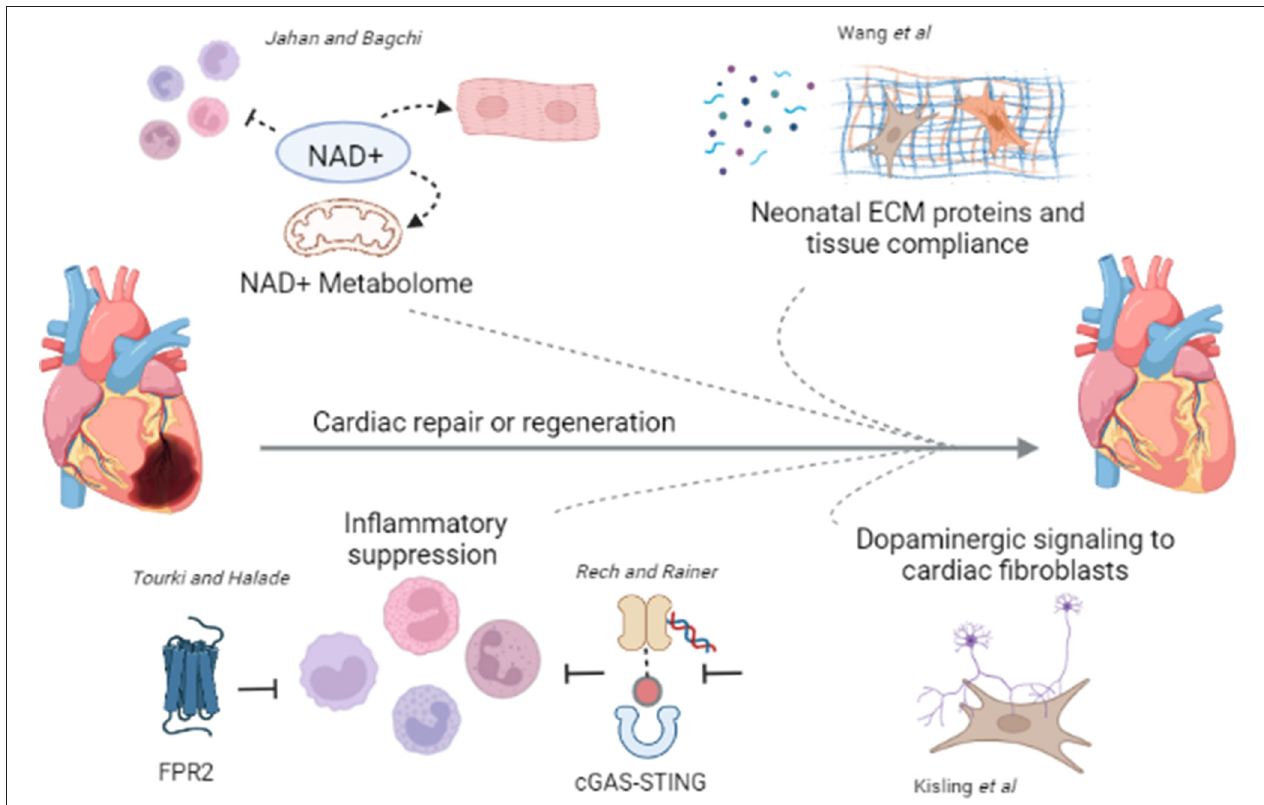
FIGURE 1 | Broad and diverse mechanisms contribute to cardiac repair or regeneration. In the current topic issue, articles review the literature regarding NAD + metabolome in CVD (Jahan and Bagchi), and inflammatory suppression via FRP2 activation (Tourki and Halade) or cGAS-STING inhibition (Rech and Rainer) in cardiac repair. Primary research articles demonstrate a role for ECM proteins and tissue compliance in cardiac regeneration ( Wang et al.), and dopaminergic signaling to cardiac fibroblasts in cardiac repair post MI (Kisling et al.). Future studies should assess what molecular triggers can tip the balance to limit adverse remodeling and the pathogenesis of HF promoting the reparative processes. Figure was generated using